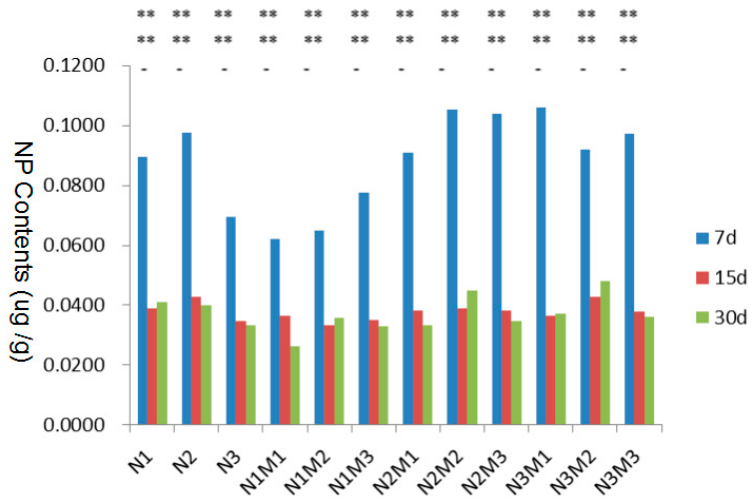
Figure 2. Statistical analysis of the content variation of 4-NP in muscle at Day 7, Day 15 and Day 30. Table 6. Statistical analysis of 4-NP contents in muscle at Day 7.